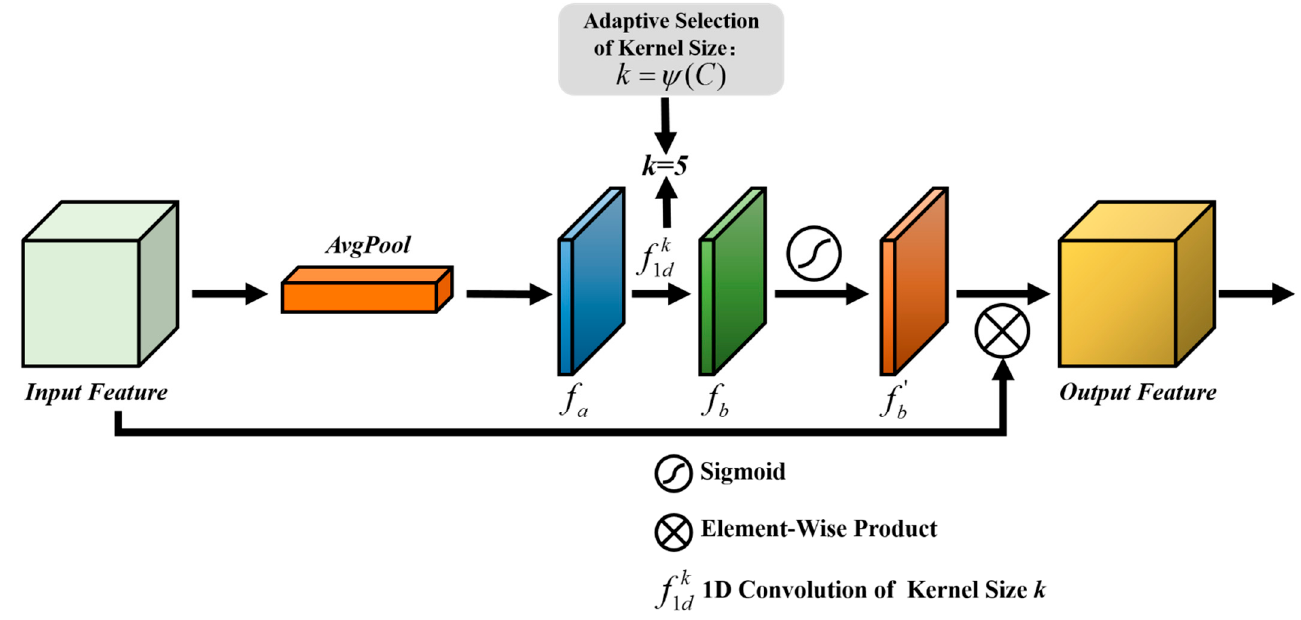
Figure 4. The details of the ECA module.